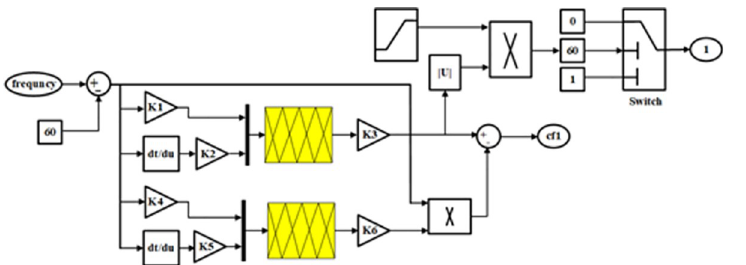
Fig 4. Block diagram of the proposed